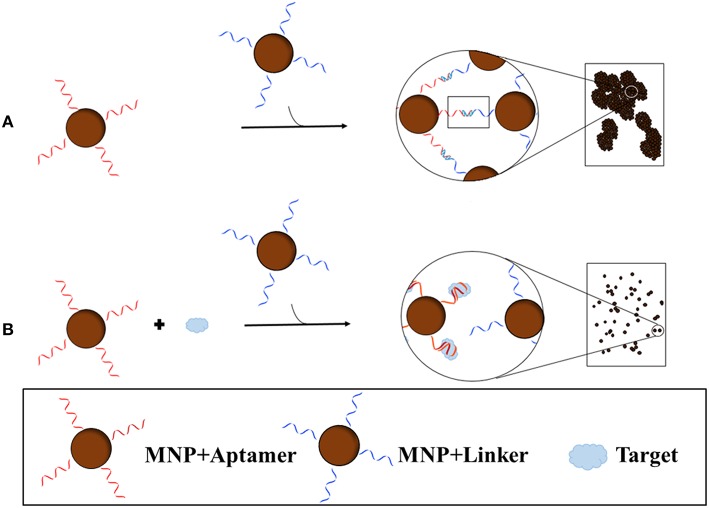
Blu-ray aptasensor scheme for the detection of target. Two types of MNPs are necessary; one MNP contains an aptamer covalently bound while the other contains a short complementary sequence of the aptamer. In the absence of target, the two MNPs form clusters as a result of the binding of the aptamer to the complementary sequence (A). In the presence of target, the MNP with the aptamer will preferentially bind the target than the complement on the other MNP and thus few or no clusters will form (B). Cluster density can then be measured by the Blu-ray unit.